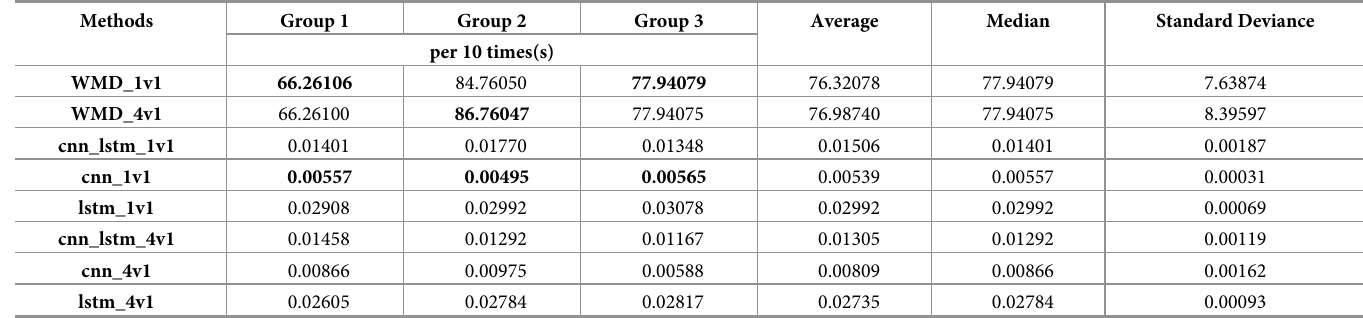
Table 2. Time consumption results of WMD and the three networks.